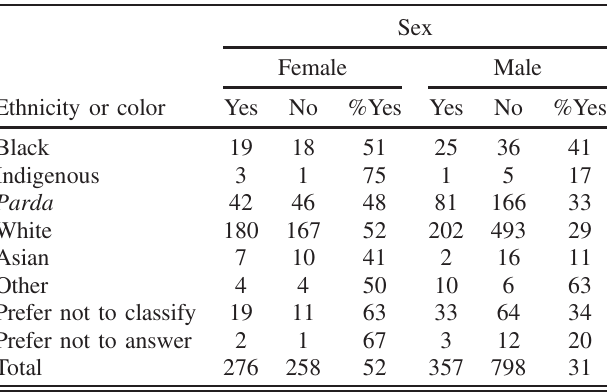
TABLE IV. Number and percentage of people who reported having suffered moral harassment (bullying), within the sub- groups of race and sex.